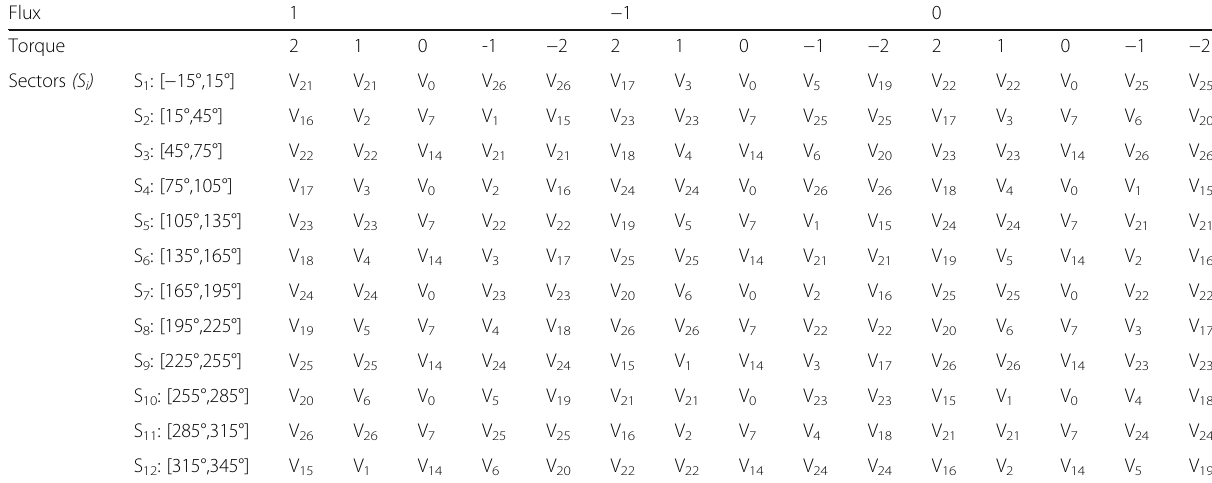
Table 4 Switching table Flux